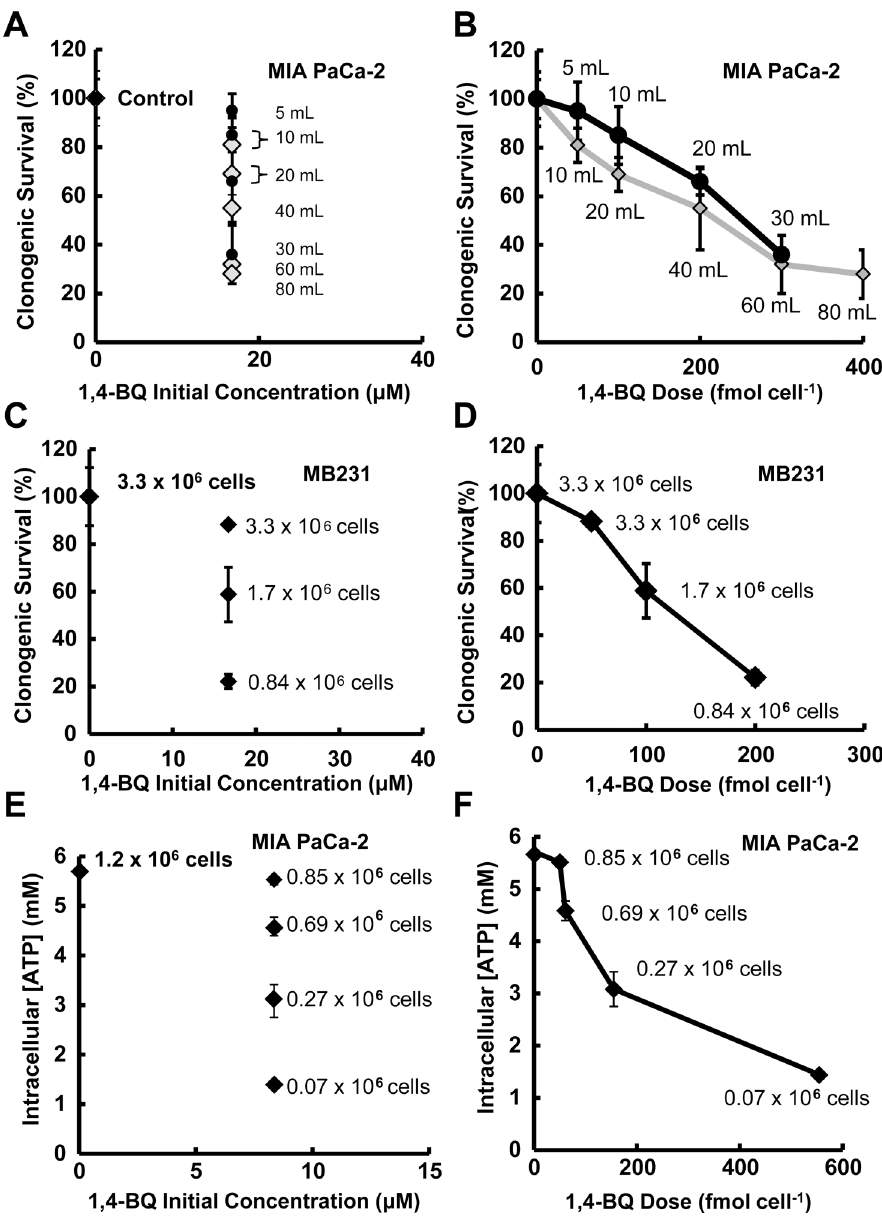
Fig 2. Dose specified as mol cell -1 more accurately reports toxicity of 1,4-BQ in cell culture experiments than initial concentration in medium. (A) These data show two different physical setups for the experiments, black circle (1.7 x 10 6 cells) and gray diamond (3.3 x 10 6 cells). Clonogenic survival of MIA PaCa-2 cells was measured in triplicate after a 4-h exposure to 16.7 μ M 1,4-BQ in different volumes of medium, yielding a range of doses on a mol per cell basis. No dose dependence is observed when the dose 1,4-BQ is expressed as the initial concentration in the culture medium. Error bars represent the standard deviation of the median of triplicate measures. (B) The data of panel A are transformed to express the dose of 1,4-BQ in units of fmol cell -1 . A far better delineation of the dose-dependent toxicity is observed in each of the two sets of experiments. Error bars represent the standard deviation of the median of triplicate measures. (C) Using a varying number of MDA-MB231 cells, clonogenic survival varied considerably after a 4-h exposure to 16.7 μ M 1,4-BQ in 10.0 mL of medium in T-25 culture flasks (each point has n = 2 for biological replicates, n = 3 within each replicate). Error bars represent the standard deviation of the mean. (D) As with MIA PaCa-2 cells, when the dose of 1,4-BQ is expressed in units of fmol cell -1 , a much more informative delineation of the dose-dependent toxicity in MDA-MB231 cells is observed. Error bars represent the standard deviation of the mean. ( E ) Using a varying number of MIA PaCa-2 cells, intracellular ATP concentration of MIA PaCa-2 cells